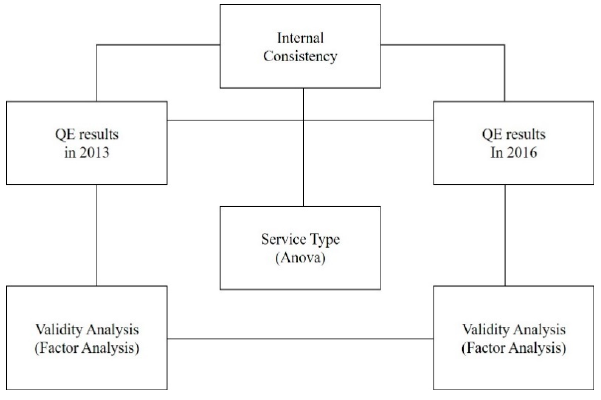
Figure 1. Framework of the research. QE: quality evaluation.